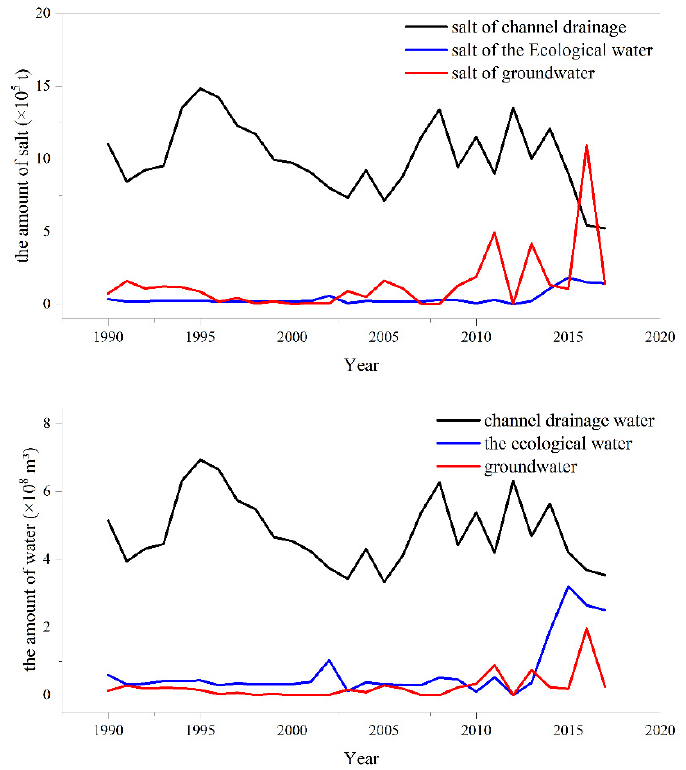
Figure 5. The water and salt evolution of Wuliangsu Lake.